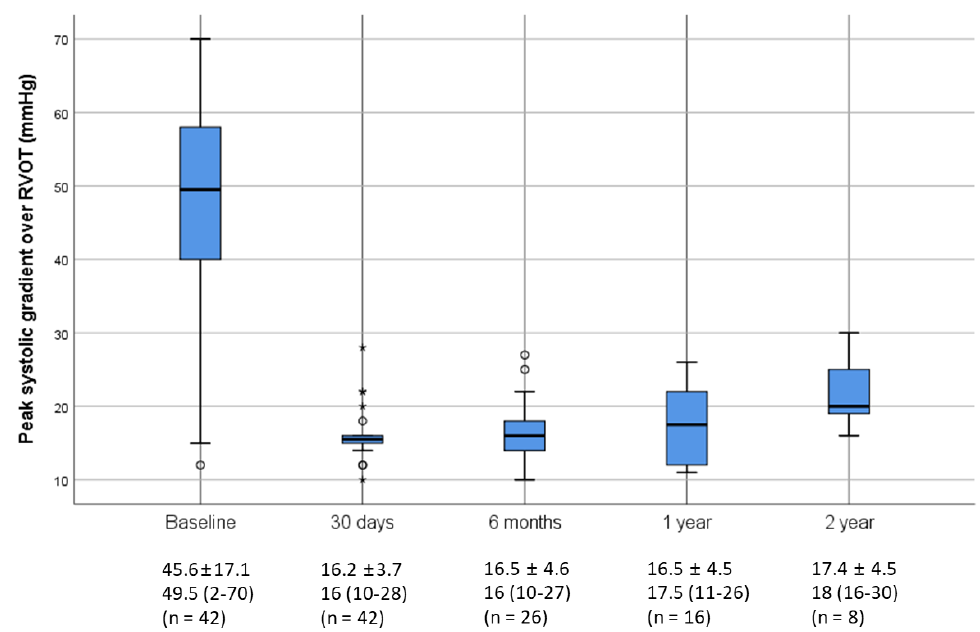
Figure 1. Peak pressure gradients between the right ventricle and the pulmonary artery before and after valve implantation by transthoracic echocardiography. There was no significant pulmonary valve stenosis over time. Values are presented as either the mean ± standard deviation or median (interquartile range). The box plot uses the median and the lower and upper quartiles (defined as the 25th and 75th percentiles). Extreme outliers are marked with an asterisk (*) on the boxplot. Mild outliers are data points that are more extreme than interquartile range, marked using a circle (o). RVOT, right ventricular outflow tract. J. Clin. Med. 2020 , 9 , x FOR PEER REVIEW